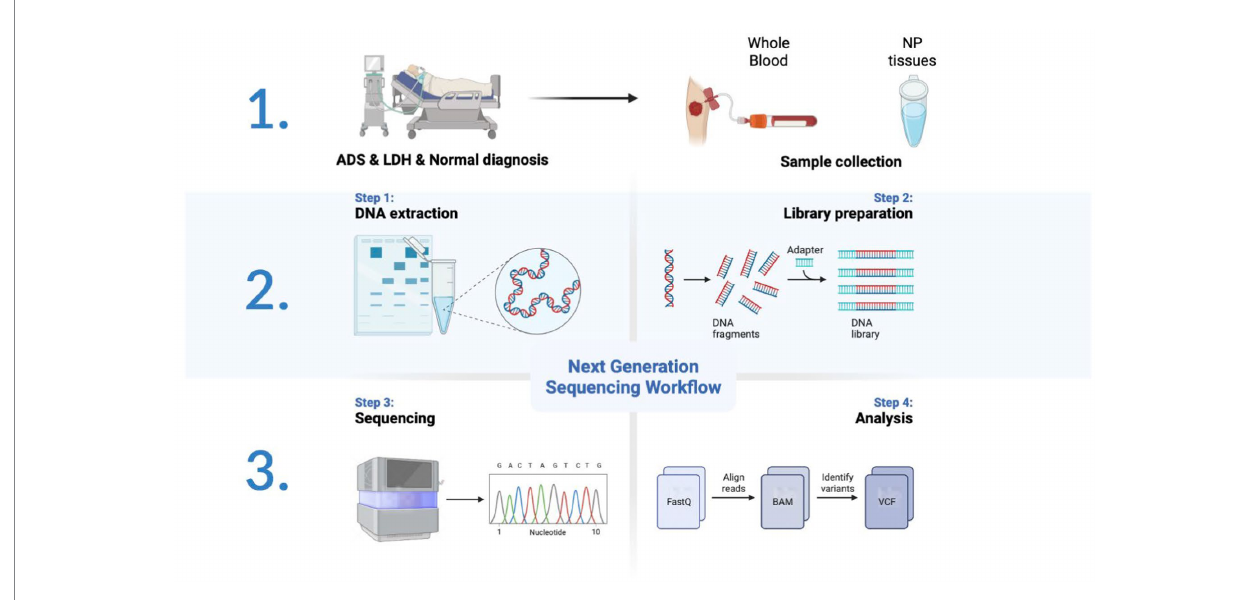
FIGURE 1 Schematic diagram of the workflow of this